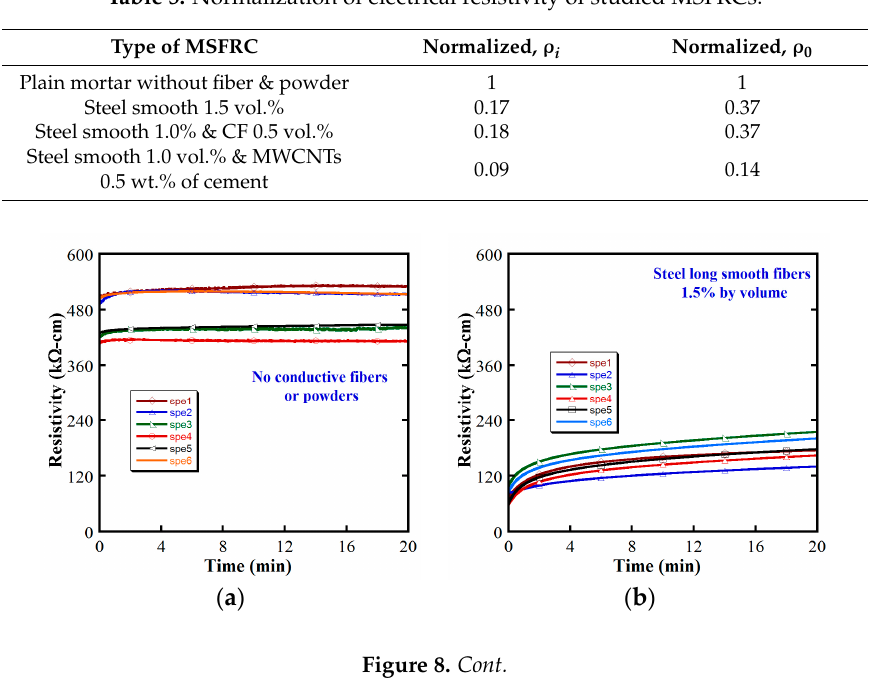
Table 4. Electrical resistivity of studied MSFRCs regarding various conductive additives.